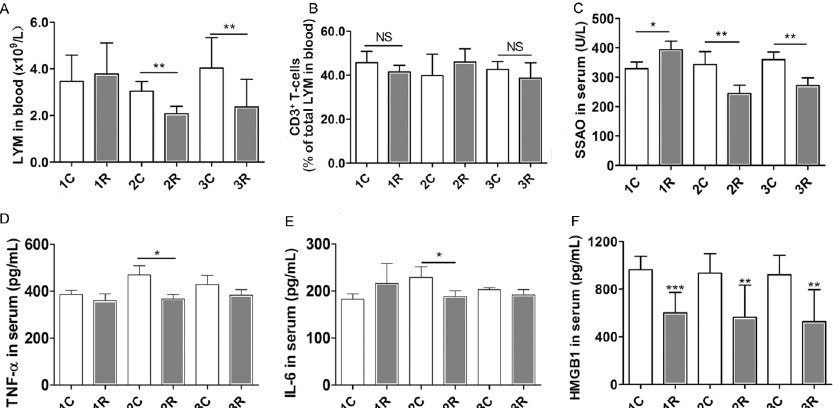
Figure 5. Immunosuppression in the peripheral blood after brain-localized carbon ion radiation. ( A ) Concentration of lymphocytes (LYM) in the peripheral blood; ( B ) Proportion of CD3 + T-cells in the peripheral blood; ( C – F ) Concentration of inflammation factors [semicarbazide-sensitive amine oxidase (SSAO), tumor necrosis factor- α (TNF- α ), interleukin-6 (IL-6), and high mobility group box-1 (HMGB1) protein in serum]. Each time point represents the results from seven rats. NS: not significant. 1C, 2C, and 3C: control rats, one, two, and three months after mock irradiation, respectively. 1R, 2R, and 3R: irradiated rats, one, two, and three months after irradiation, respectively. * p < 0.05, ** p < 0.01, *** p < 0.001.